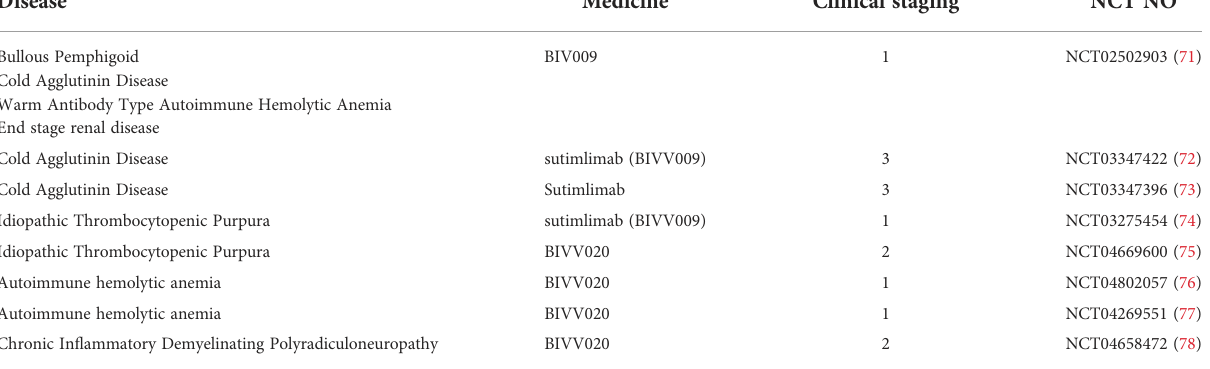
TABLE 1 Registered clinic trials with C1s targeted